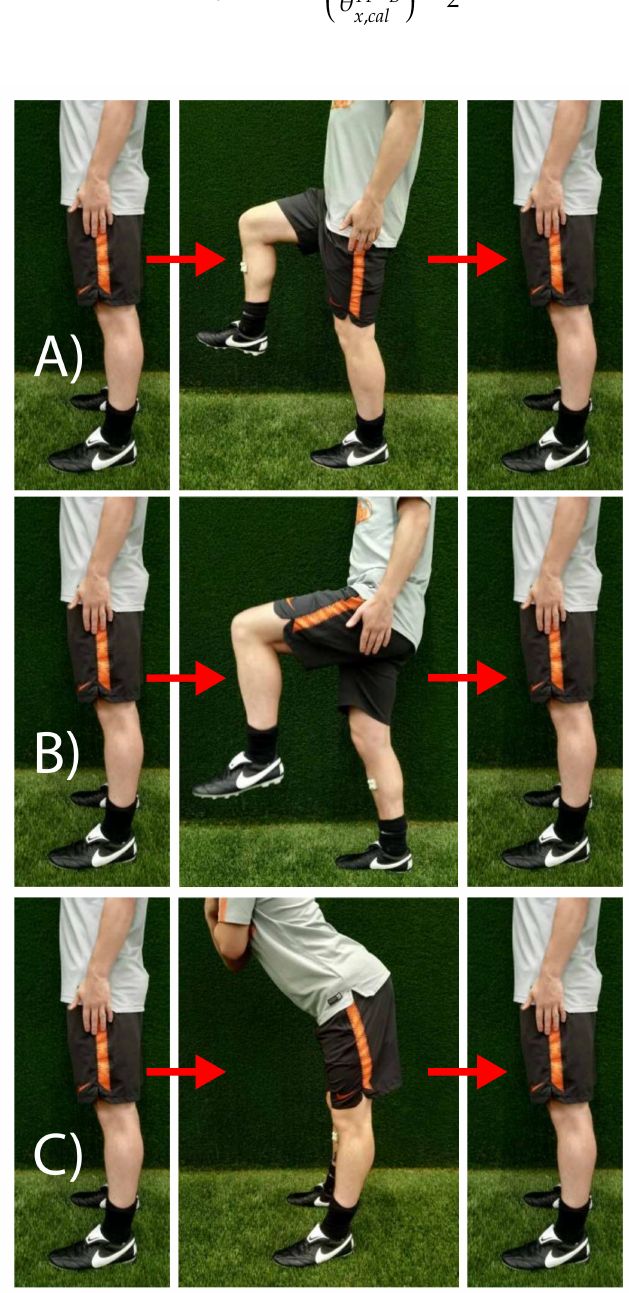
Figure 2. Calibration movements. Photographic representation of functional calibration procedures: ( A ) Rise of right leg, ( B ) rise of left leg, ( C ) bow